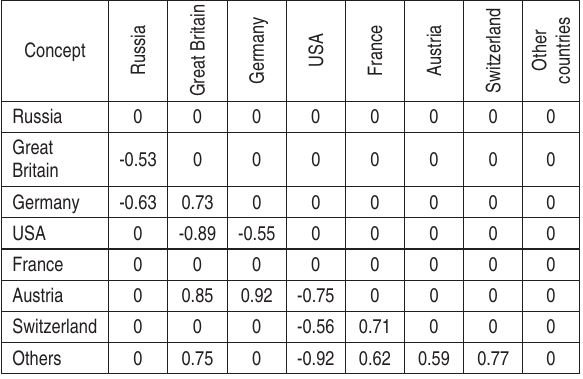
Table 2. Matrix of the mechanism of regulation of reinsurance between